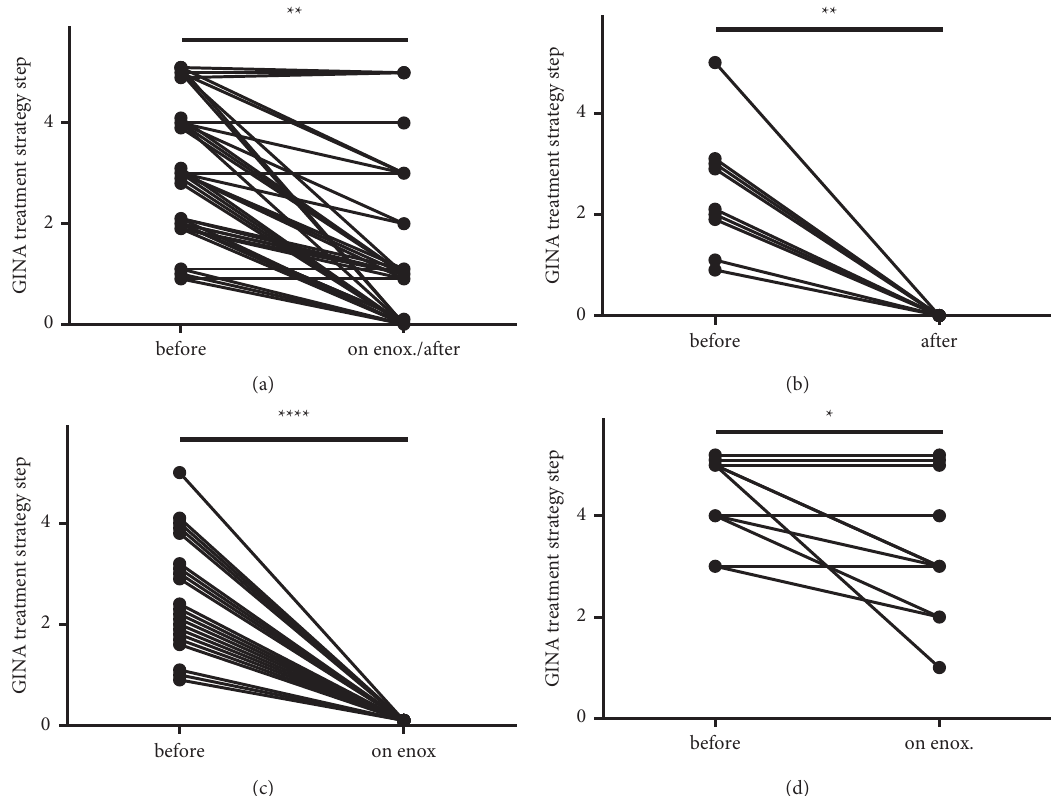
Figure 1: Asthma patients were able to phase down asthma medication when enoximone was taken (ICS use reduction according to GINA guidelines). Asthma patients were treated at least 3 months with enoximone ( n � 41; enoximone 15–105 mg/week (in 1–7 dosages)). (a) Asthmatic patients ( n � 41) using or having used enoximone (on enox./after). (b) No traditional asthma medication was needed any more ( n � 9). (c) Only enoximonetherapy with incidental SABA/LABA ( n � 21). (d) Enoximone together with ICS ( n � 11) (Wilcoxon matched-pairs signed rank test ∗ � p < 0 . 05; ∗∗ � p < 0 . 01; ∗∗∗ � p < 0 . 001) (enox. �